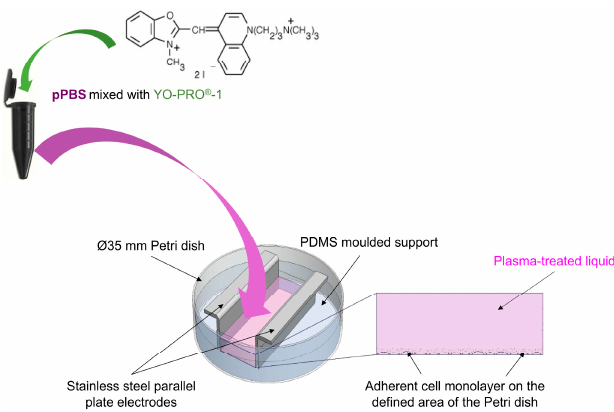
Figure 10. Schematic illustration of the electropulsation setup used in the combined treatment.